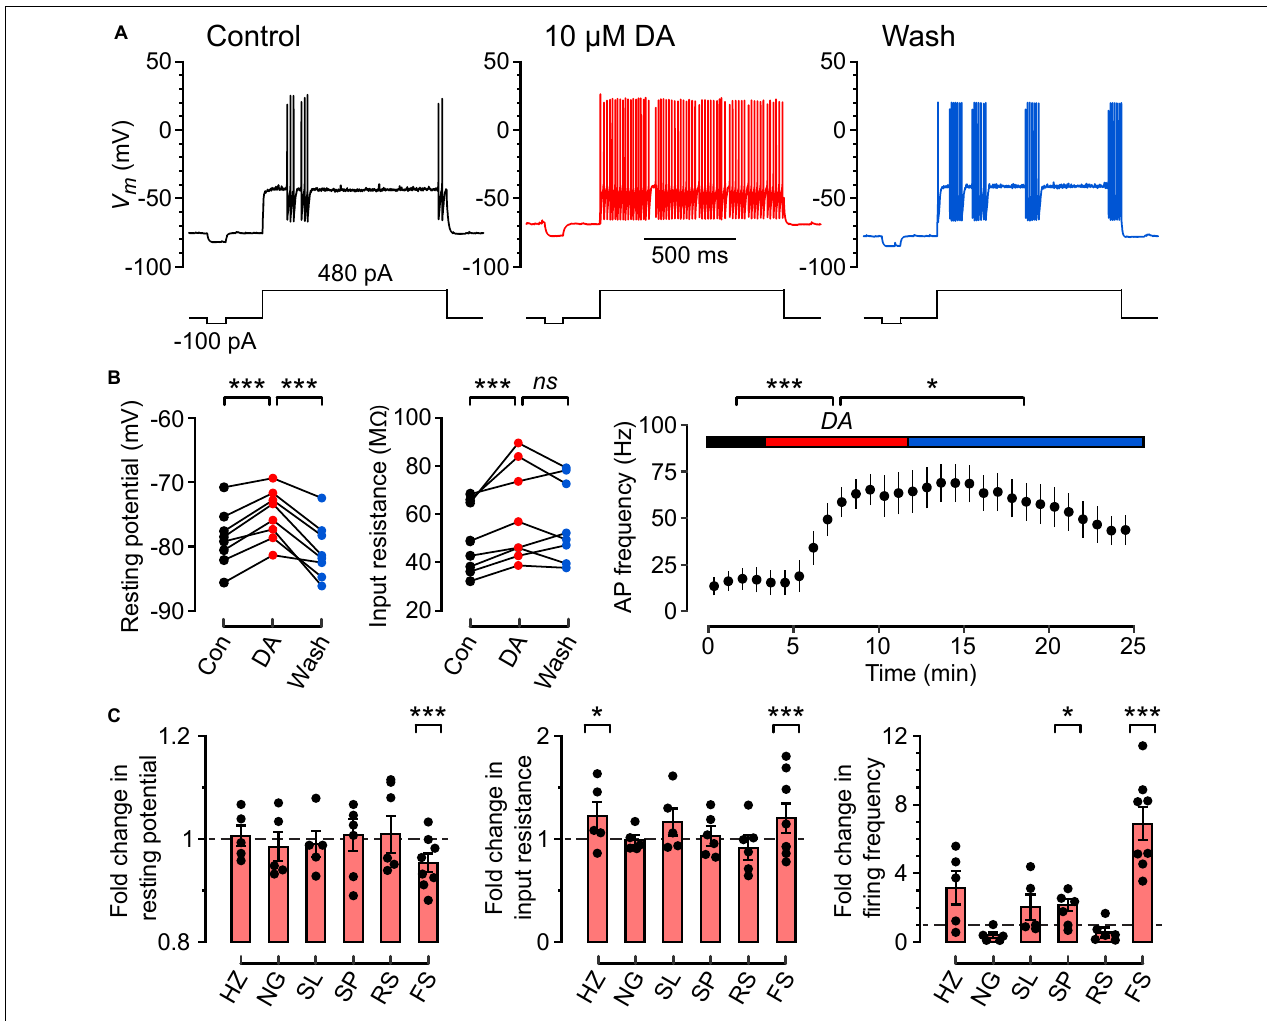
FIGURE 2 | Dopamine depolarizes the resting potential, increases the input resistance and increases the frequency of firing of FS cells in response to a constant suprathreshold current step. (A) Typical action potential firing patterns of an FS cell during control (black), dopamine (DA) (red) and wash (blue) in response to a constant 480 pA current step. A separate current step (-100 pA) was also injected to monitor input resistance. (B) (Left), Resting potentials of FS cells ( n = 8) in control, DA and wash; lines connect data points for each cell. (B) (Middle), Input resistances measured for the same FS cells. (B) (Right), Plot of mean